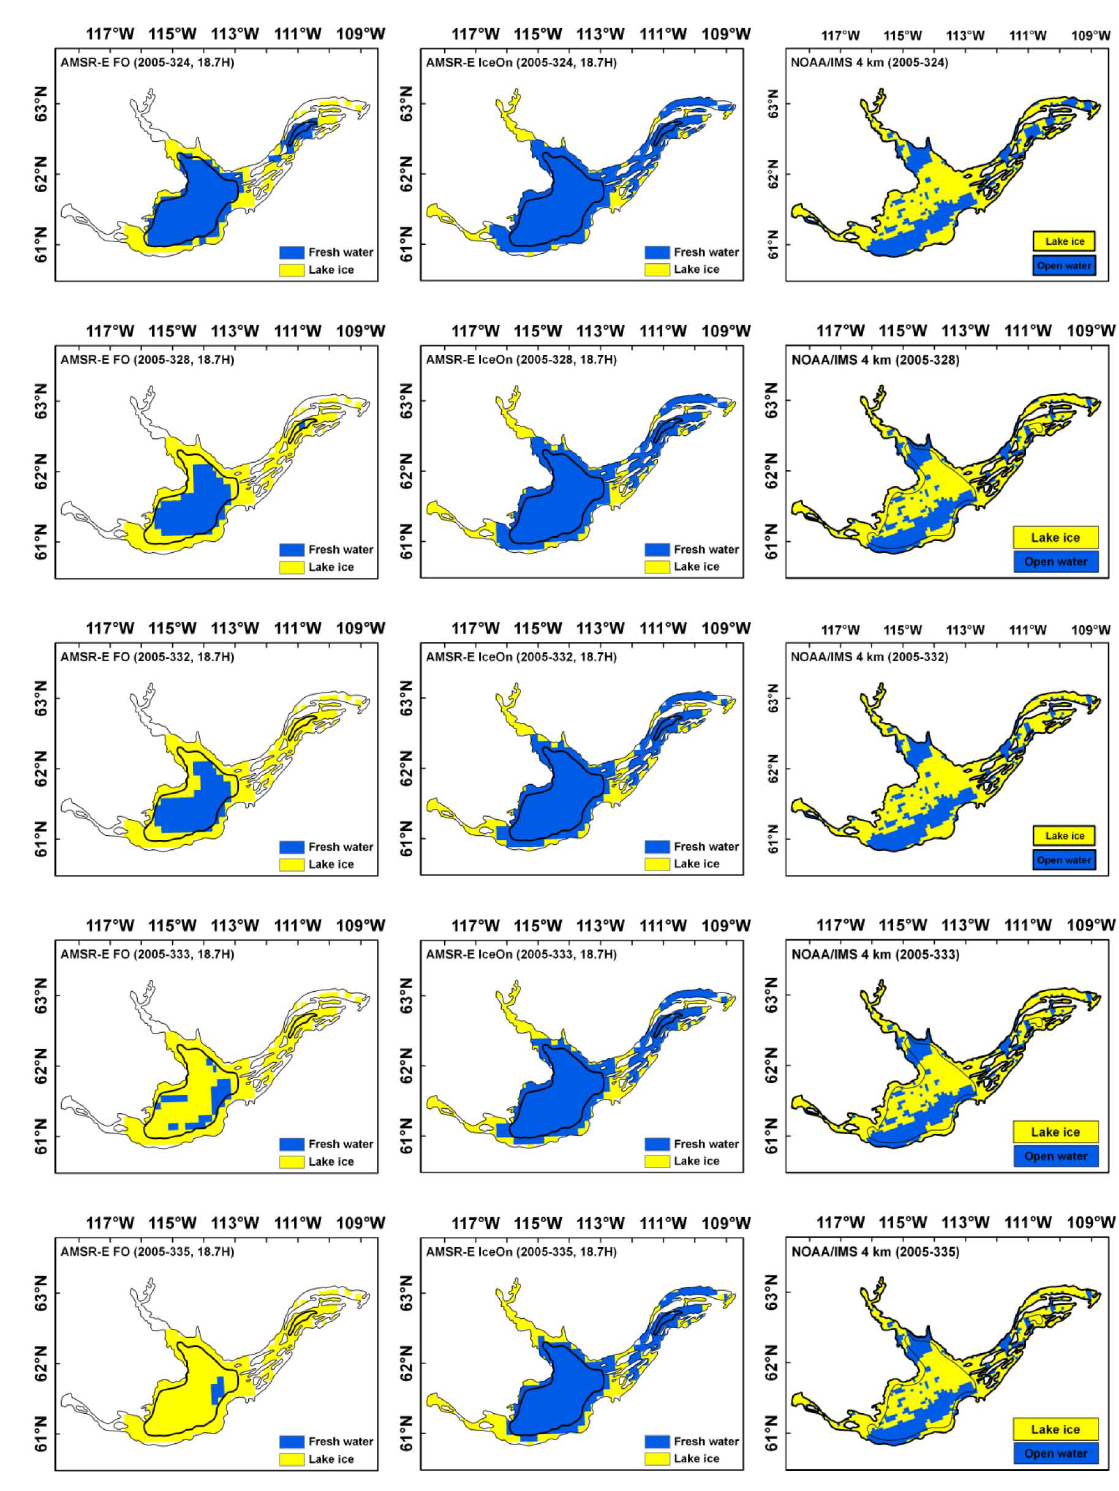
Fig. 7. Comparison of AMSR-E freeze-onset (left), ice-on (center), and NOAA/IMS ice-on (right) (day of year) during the freeze-up period of ice season 2005–2006 on